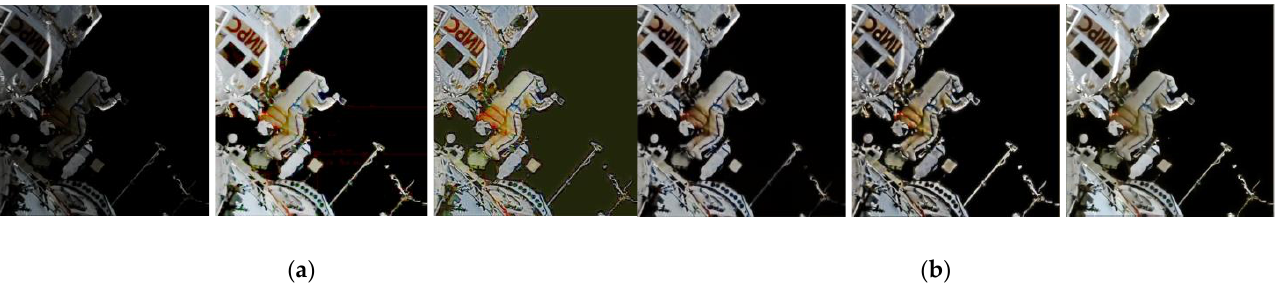
Figure 10. Different algorithms in low-illumination environments that can be used by astronauts for extravehicular space image enhancement. ( a ) Low-illumination MSRCR RetinexNet; ( b ) KinD MBLLEN Ours.